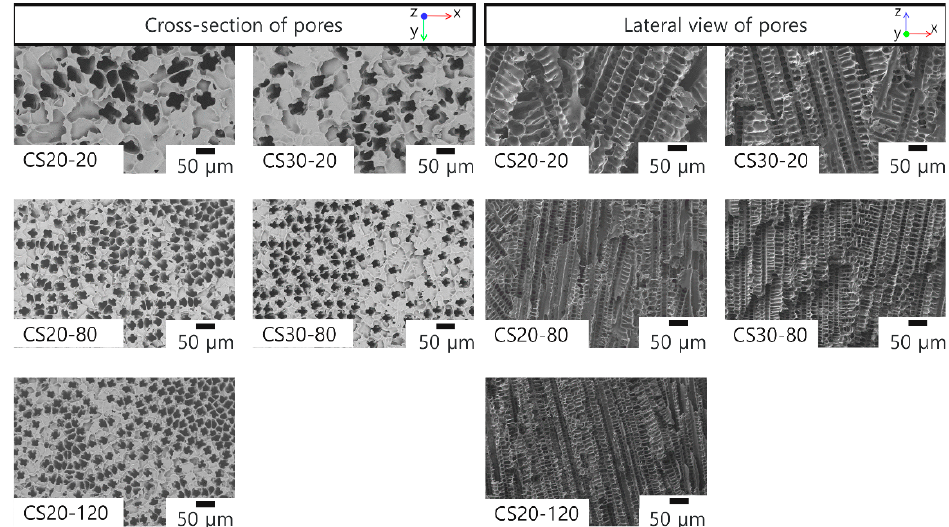
Figure 5. SEM pictures of pore morphology for the center position of the samples. Images of cross- section and lateral view with pores perpendicular and parallel to the freezing direction, respectively.